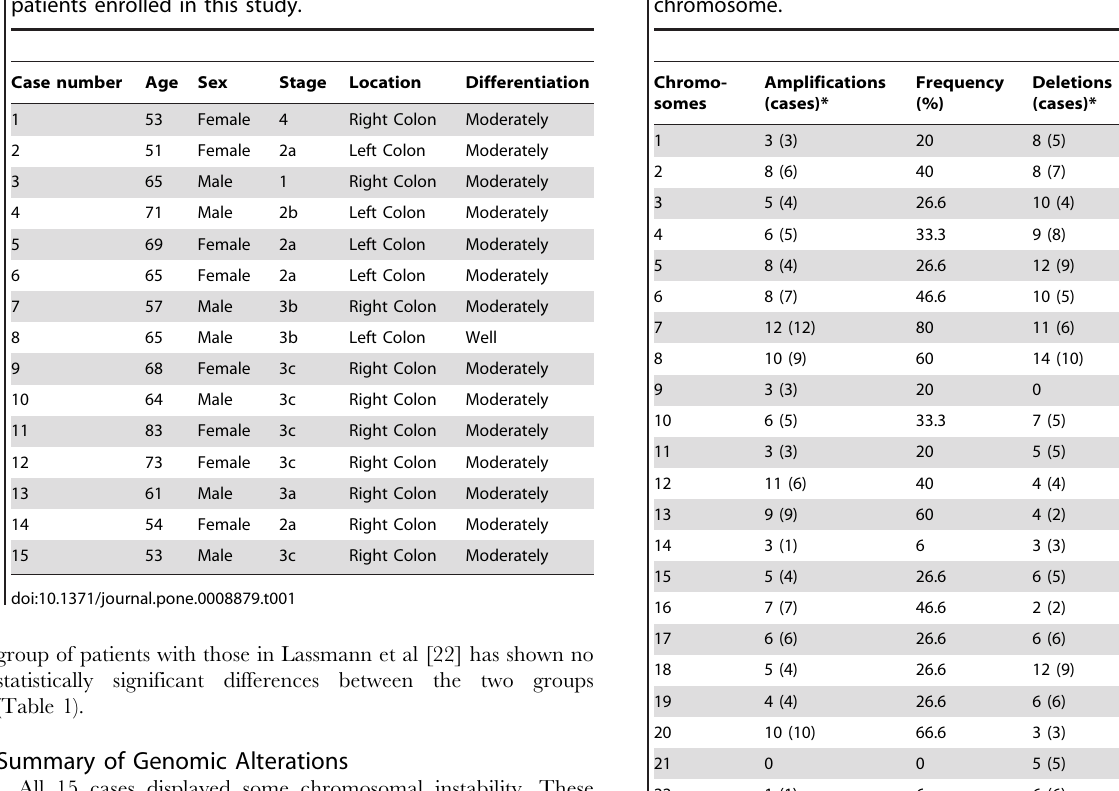
Table 1. Clinical and demographic characteristics of the 15 patients enrolled in this study.